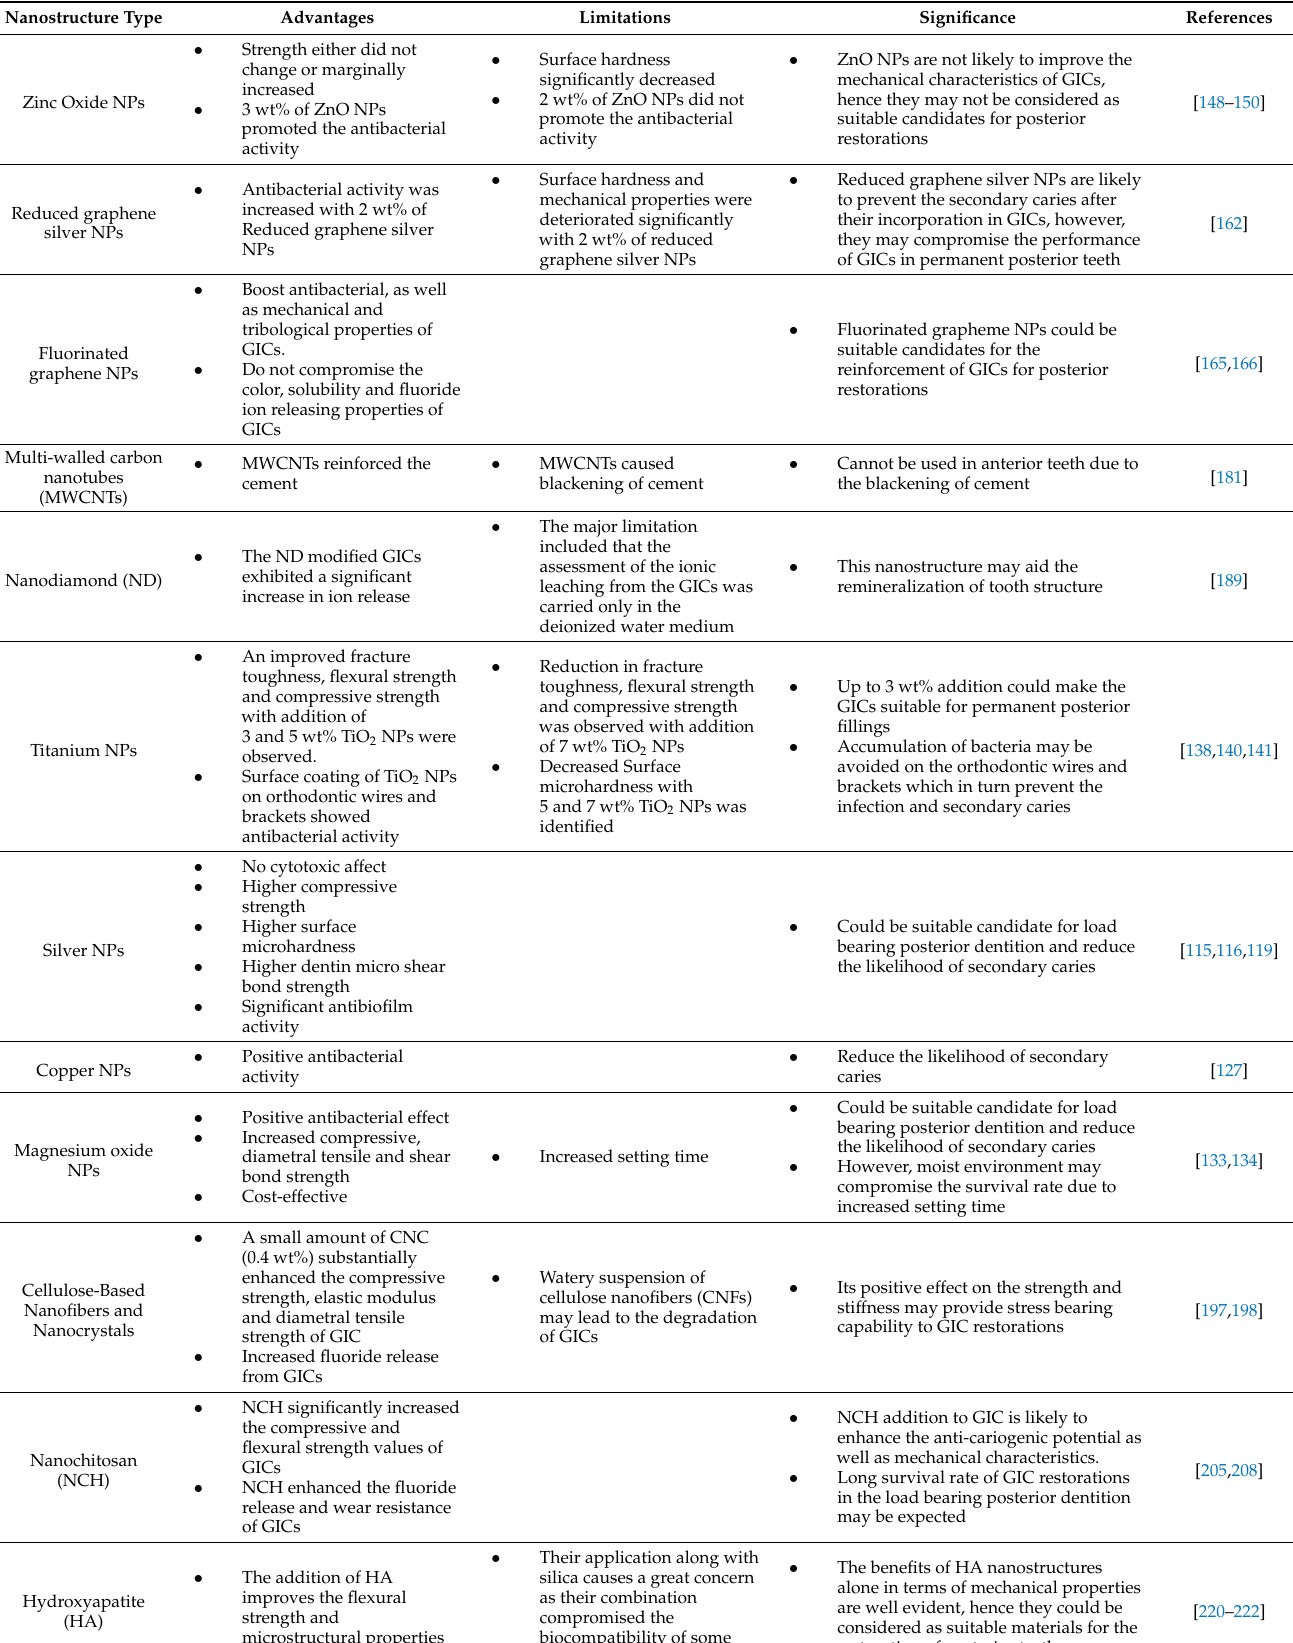
Table 2. Advantages, limitations and clinical significance of various nanostructures in